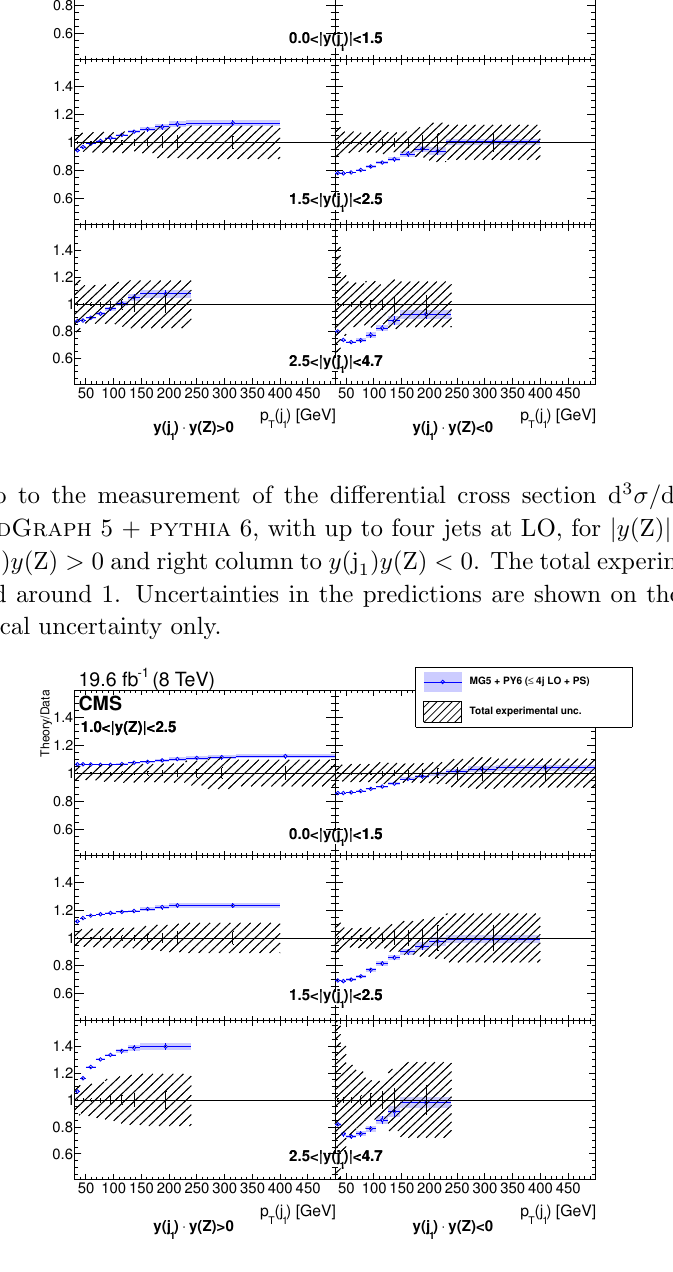
)d y (j )d y (Z) 1 1 ) y (Z) < 0. The total experimental 1